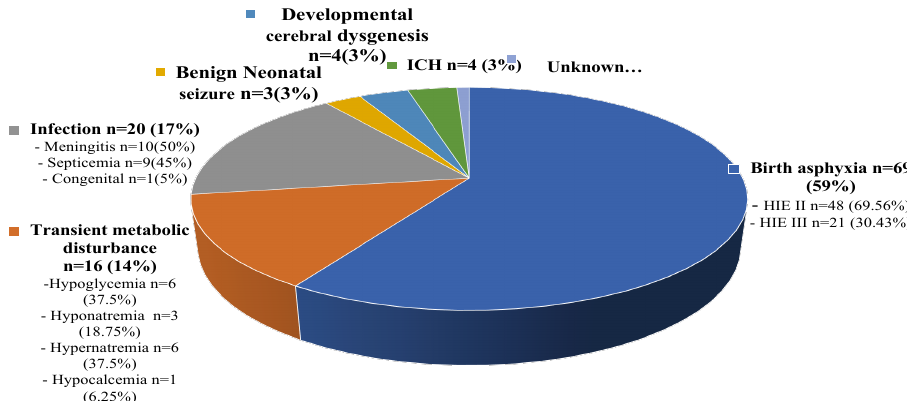
Fig. 1. Etiological Distribution of Neonatal Seizure (N=117)